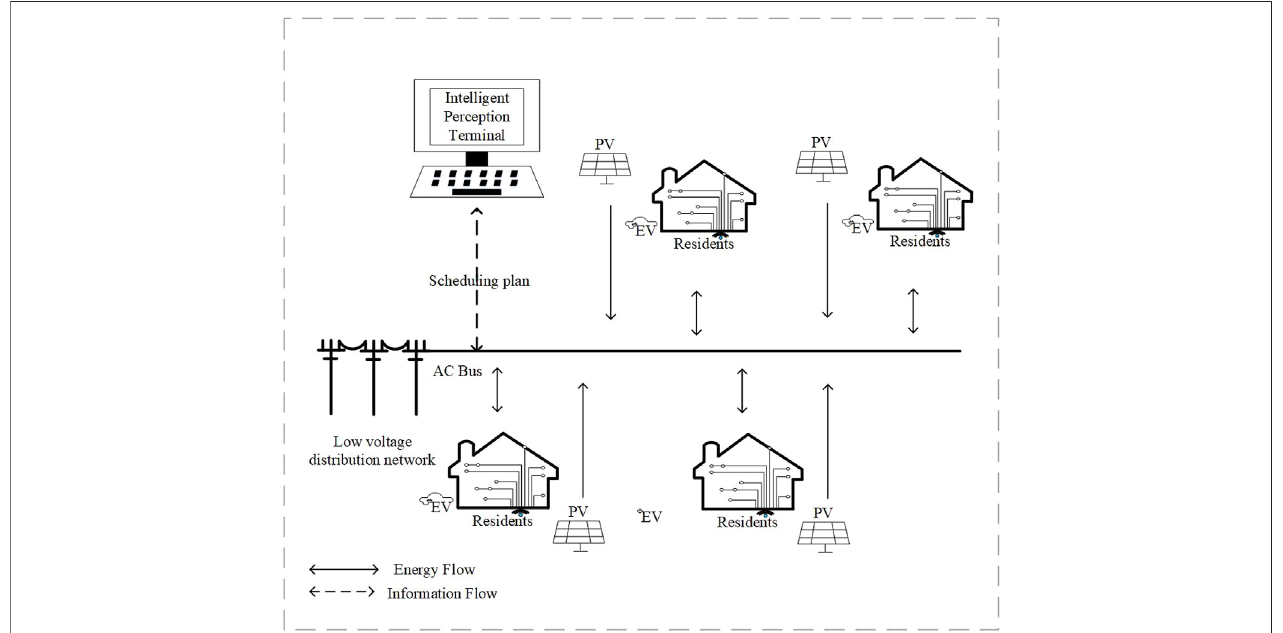
FIGURE 1 | Energy fl ow and information fl ow under power sharing